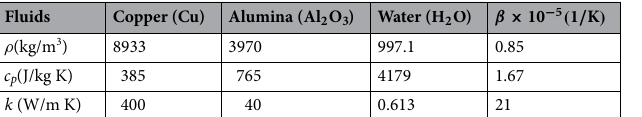
Table 2. The properties of thermos physical 20,21